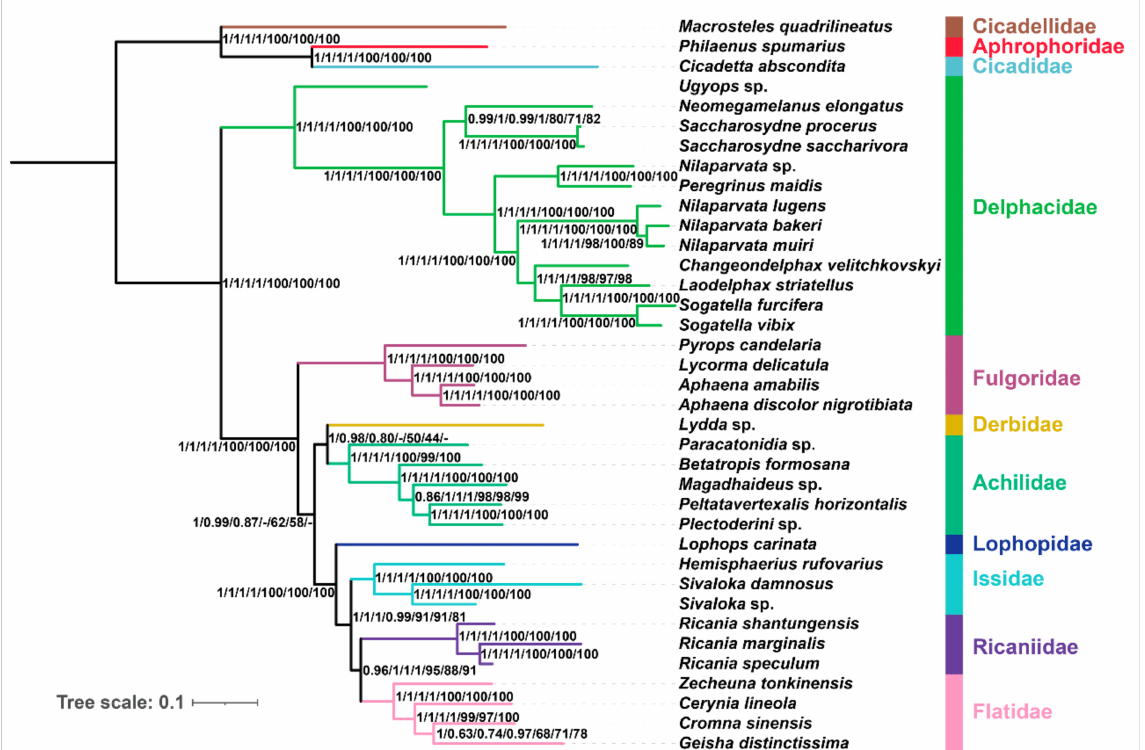
Figure 7. Phylogenetic tree inferred from IQ-TREE and MrBayes based on the datasets of AA, PCGRNA, PCG, and PCG12RNA. Supports at nodes (from left to right) are Bayesian posterior probabilities (PP) for AA, PCGRNA, PCG, PCG12RNA, and then ML bootstrap support values (BS) for PCGRNA, PCG, PCG12RNA. “-” indicates the clades are